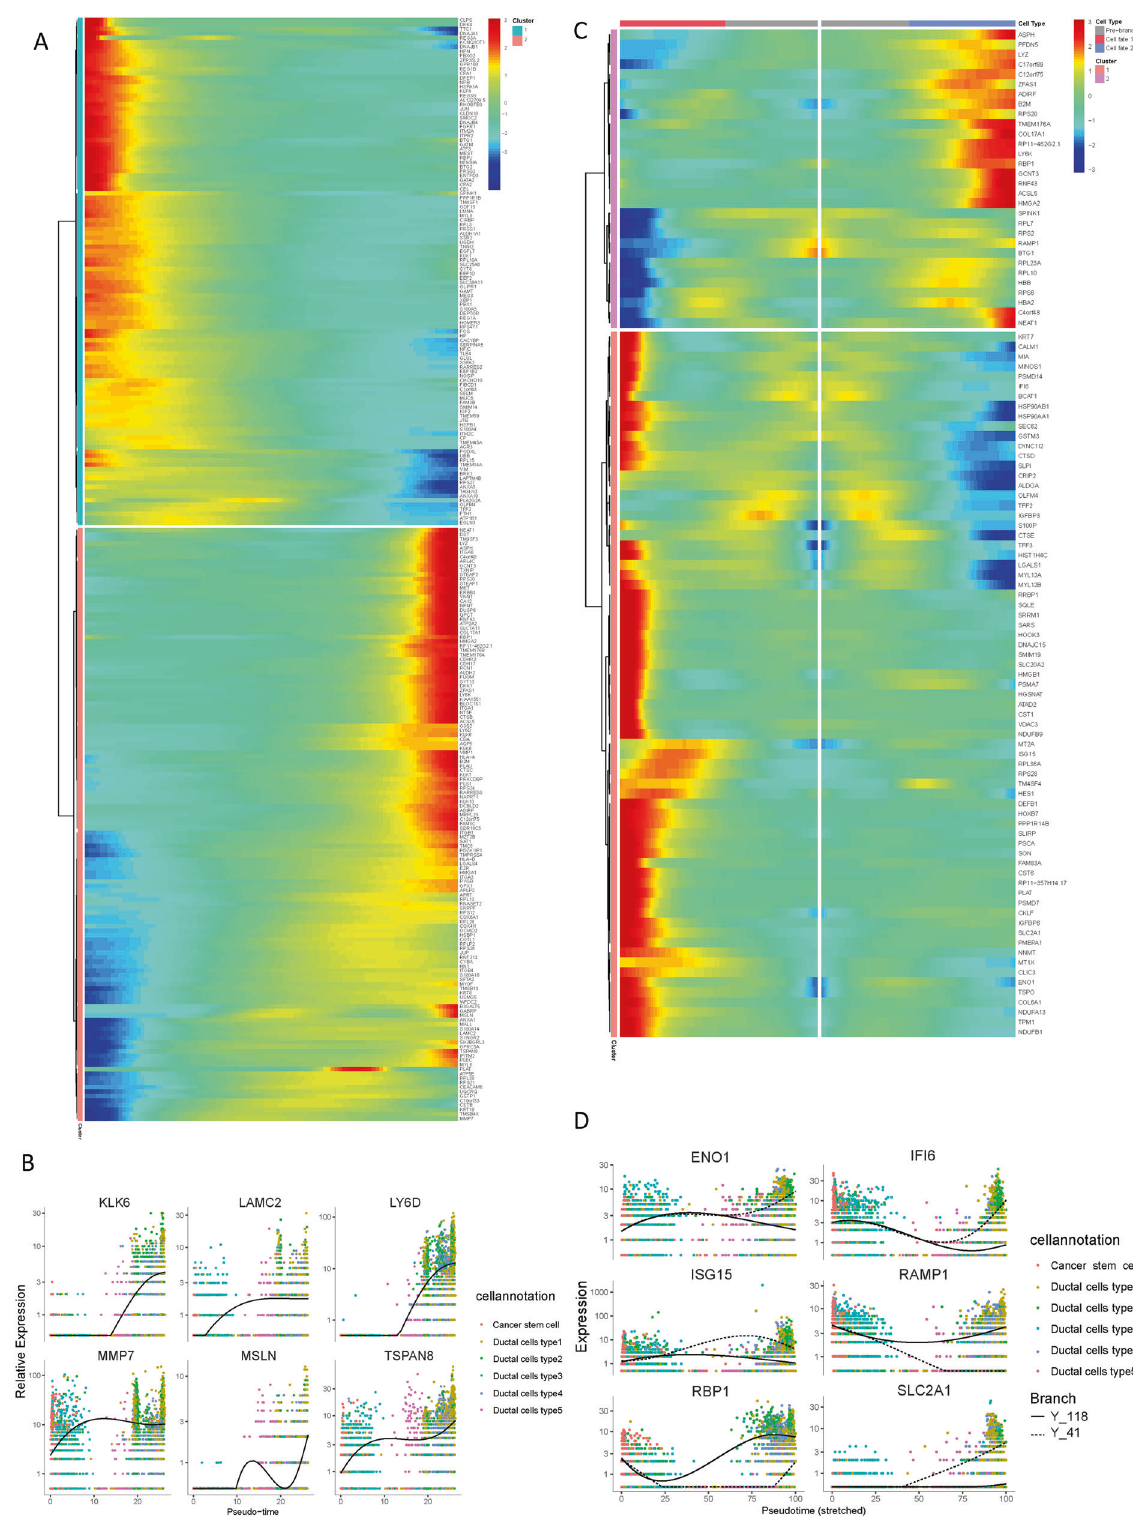
Fig. 5 Differential gene expression pro fi les along malignant progression. A Heatmap hierarchical clustering showing differentially expressed transcription factor genes along with the pseudotime curve. Color key from blue to red indicates relative expression levels from low to high. B Expression patterns of representative differentially expressed genes in the progression process. C The pseudotime heatmap displayed the differentially expressed genes between the branches according to the BEAM analysis. Color key from blue to red indicates relative expression levels from low to high. D Expression patterns of representative differentially expressed genes between different branches in the progression process.